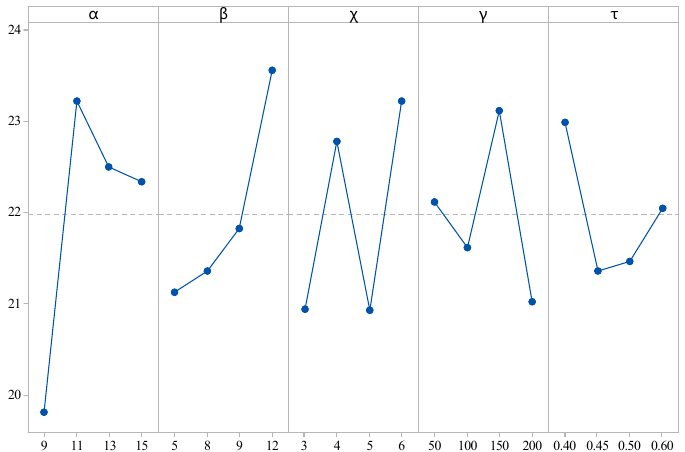
Figure 4. SNR main effects plot.